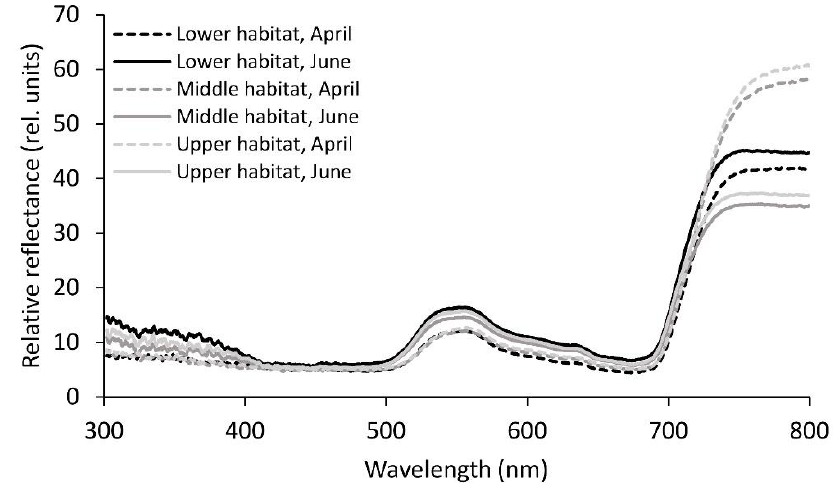
Figure 3. Mean relative reflectance spectra from 300 to 800 nm for the Phyllitis scolopendrium fronds from the three different habitats, sampled in April and June. The data were smoothed using moving averages with a period of five consecutive measurements (n = 10).